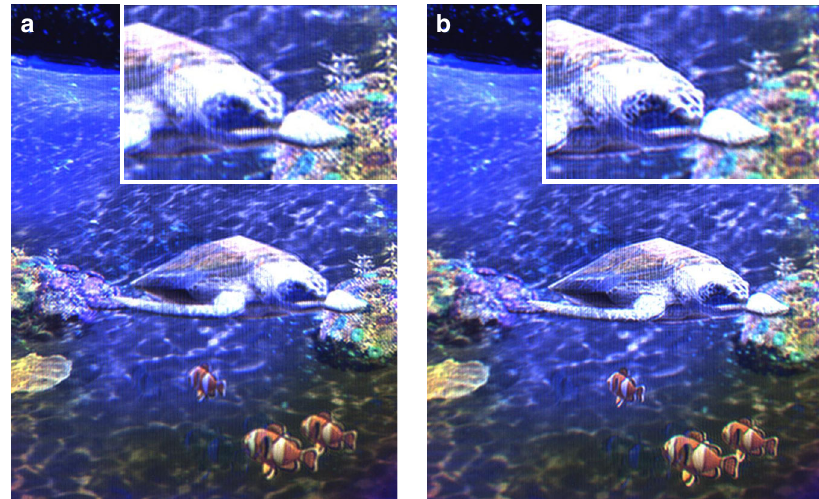
Fig. 6 Full colour real-time holographic movie. Photos are taken from a holographic video display when it is focused. a 0.1 m behind the display and b 0.35 m in front of the display: for the comparison between the images, expanded images are shown in the upper right corners respectively. The movie clip is available in Supplementary Movie 2, where interactive holographic colour images are shown at 30